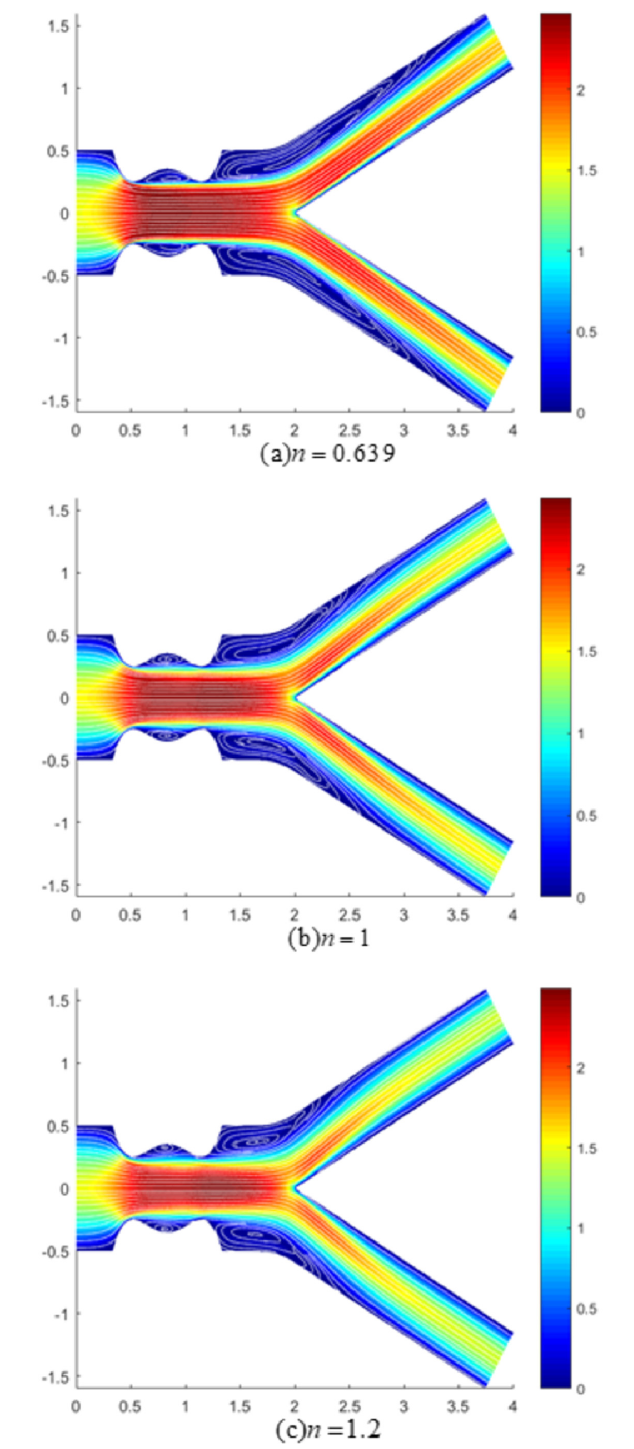
Fig 12. Velocity contour with streamlines pattern for (a) n = 0.639 (shear-thinning), (b) n = 1 (Newtonian) and (c) n = 1.2 (shear-thickening) fluids ( M = 8, Re = 300 and τ m = 0.4 a ).